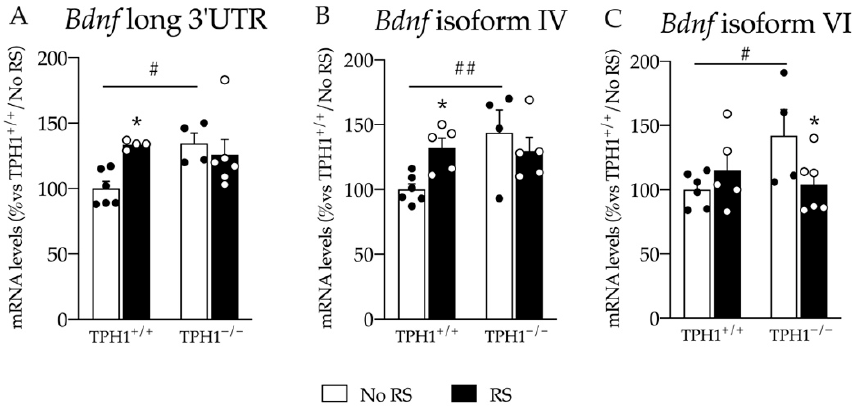
Figure 5. Analyses of Bdnf long 3 (cid:48) UTR ( A ), Bdnf isoforms IV ( B ) and VI ( C ) mRNA levels in the PFC of TPH1 +/+ and TPH1 − / − male adult rats exposed to RS and sacrificed immediately after stress. The data, expressed as percentage of TPH1 +/+ /No RS (set at 100%), are the mean ± standard error of the mean (SEM) of at least 4 independent determinations. * p < 0.05 vs. naïve for the same genotype; # p < 0.05, ## p < 0.01 vs. TPH1 +/+ for the same condition, two-way ANOVA with Fisher’s PLSD.